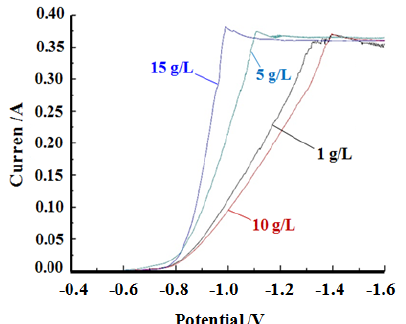
Figure 2. Curve of the effect of the presence of nanodiamond particles in the plating solution on the cathodic polarization behavior of nickel ions. cathodic polarization behavior of nickel